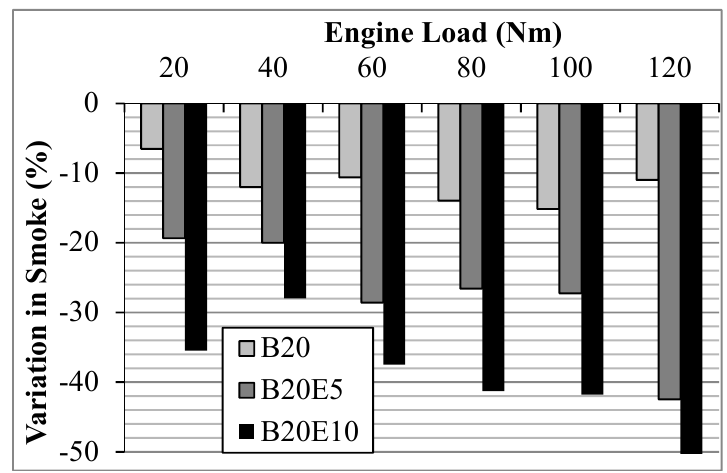
Figure 6. Variation in smoke emissions with the blends compared to diesel fuel as baseline.